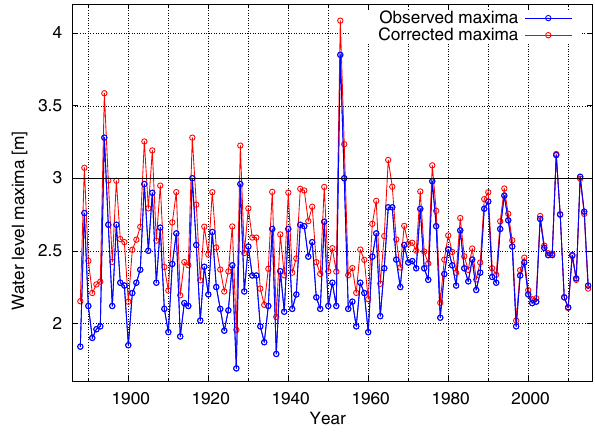
Figure 1. Adjustment of the observed sea levels in Hoek van Hol- land (1880–2015) to correct for sea level rise and land subsidence. The observational record is adjusted to be representative for the sit- uation in 2009.